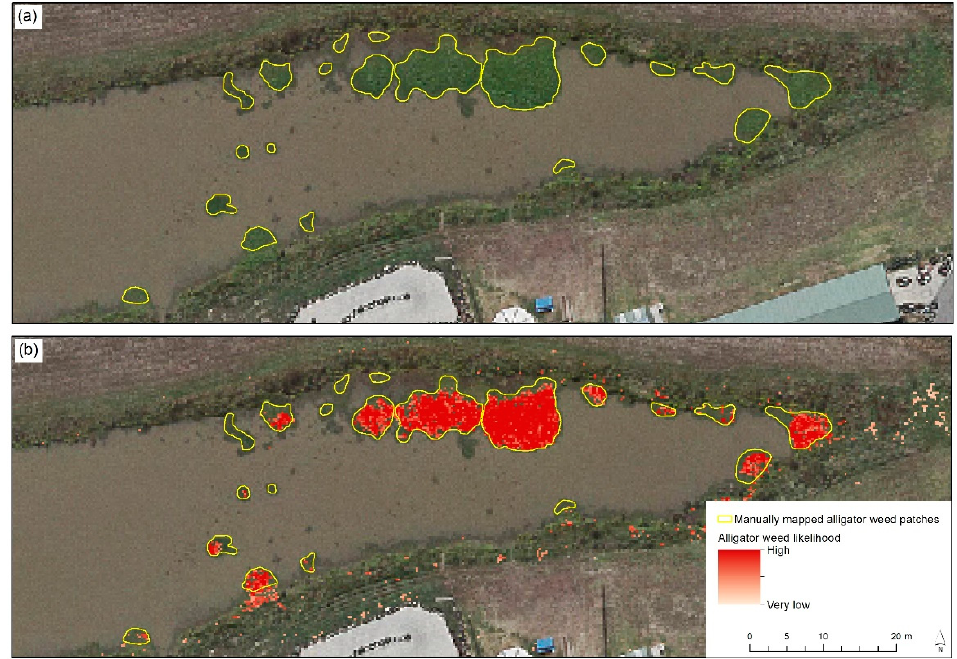
Figure 5. Example output of a waterbody in 2016 showing ( a ) manually mapped patches of alligator weed and ( b ) the corresponding alligator weed likelihood output.